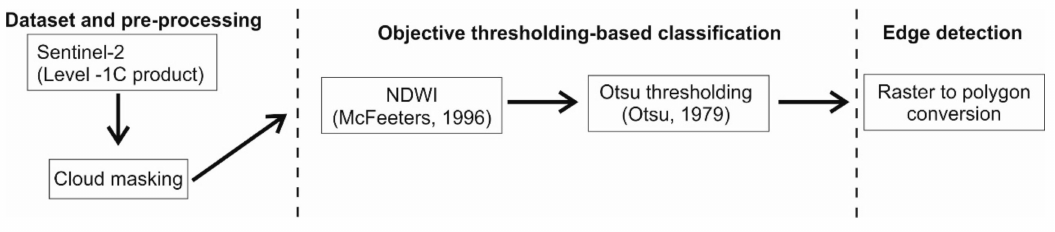
Figure 3. Workflow diagram showing the step-by-step procedure to extract